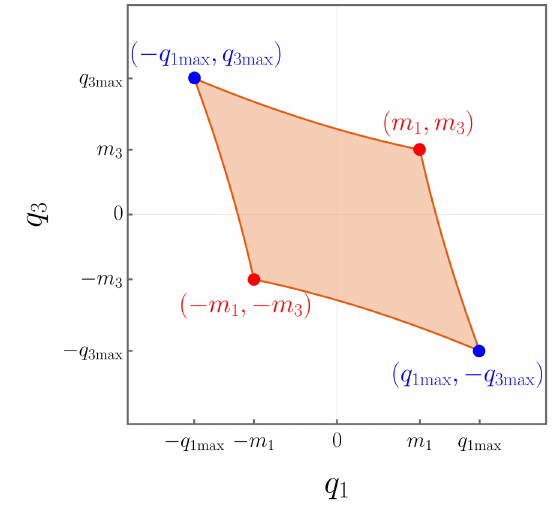
Figure 6 . Parameter space of the charges q i for given ( ‘, m 1 , m 3 ) and their BPS bounds.